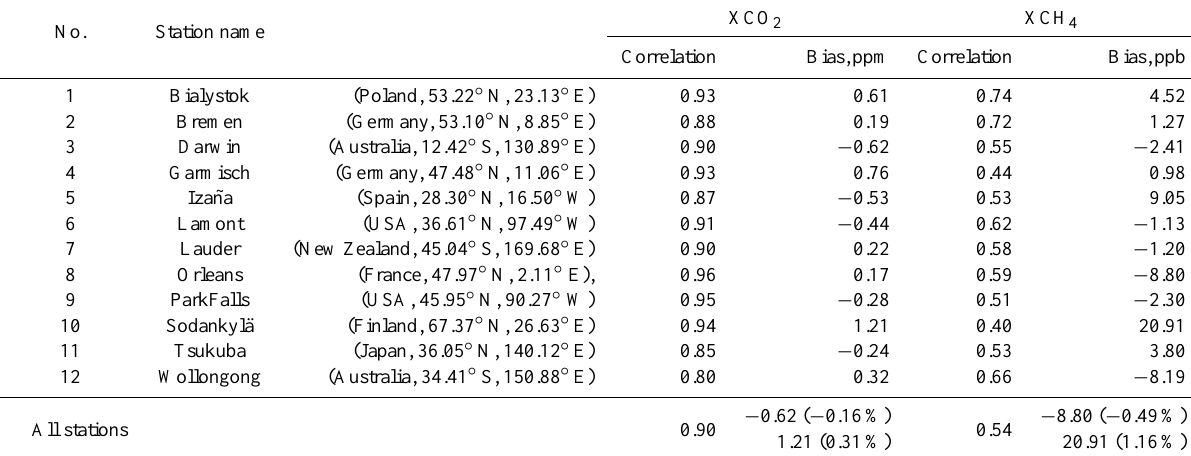
Table 3. Correlation coefficients and biases of the modelled XCO 2 and XCH 4